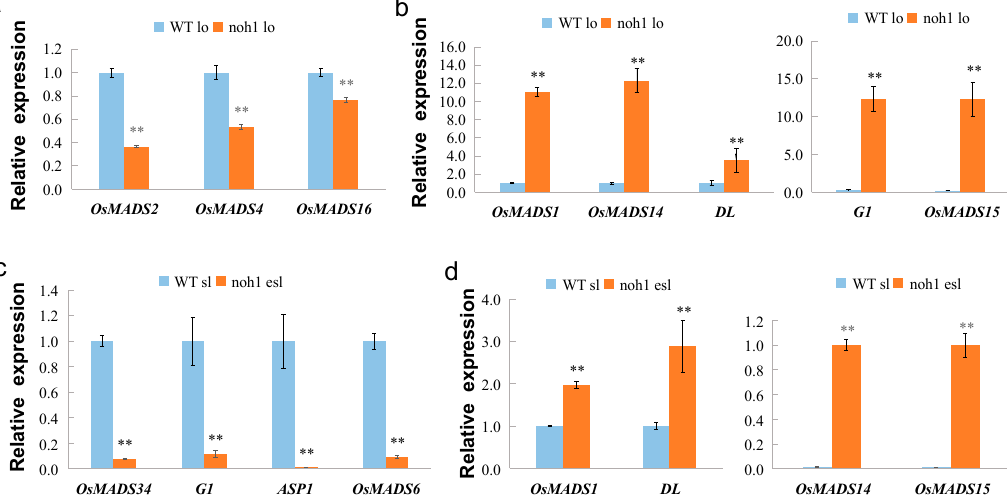
Figure 4. Relative expression levels of floral organ identity genes in the wild type (WT) and noh1 floral organs; ( a ) B class genes downregulated in the noh1 lodicule; ( b ) genes partially upregulated in the noh1 lodicule; ( c ) genes partially downregulated in the noh1 elongated sterile lemma (about 15 pairs of sterile lemmas with corresponding phenotype were collected by using a pointy tweezer to extract the total RNA); ( d ) genes partially upregulated in the noh1 elongated sterile lemma. lo: lodicule; sl: sterile lemma; esl: elongated sterile lemma; error bars indicate SD. ** indicates p <